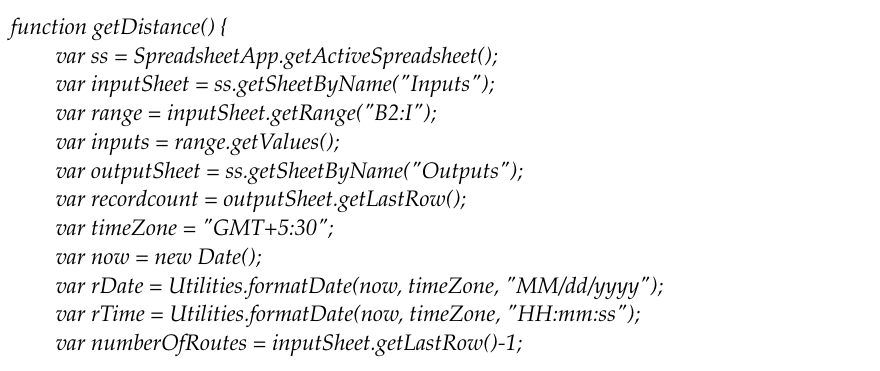
Table 2. Sample of automatic travel time and distance data from Google API.